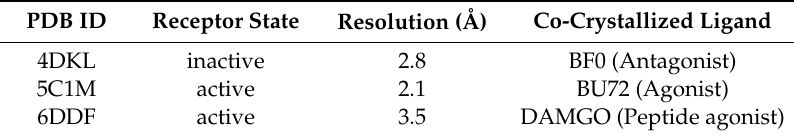
Table 2. Summary of characteristics of crystal structures used in the study.